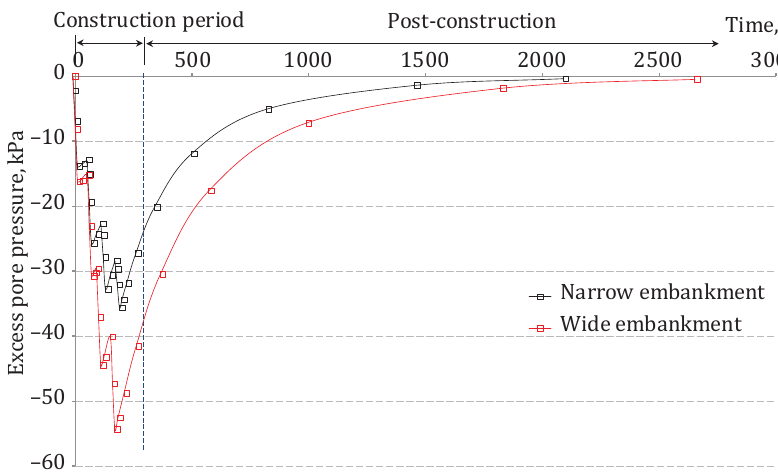
Figure 9. Variation of excess pore pressure